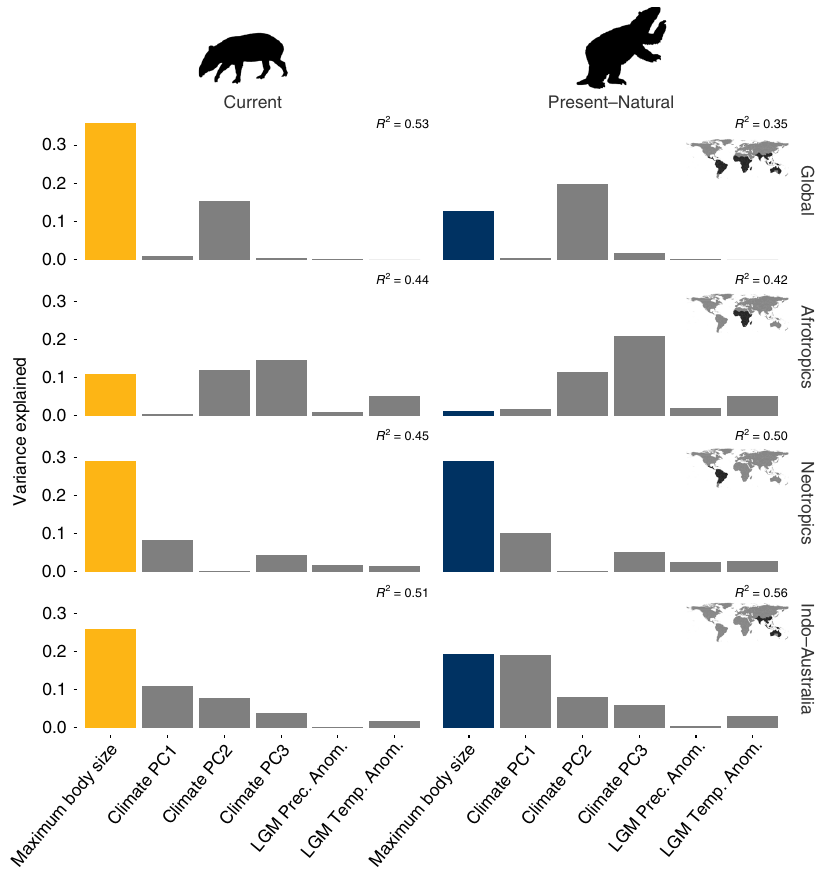
Fig. 3 Relative importance of predictors to maximum palm fruit size under current and present – natural scenarios. Bars represent the proportion of variance explained by each variable predictor in each model, and sum to the total variance explained by full ordinary least-squares (OLS) models with all predictor variables included ( R 2 ) as indicated at the top right of each panel. The bar representing the contribution of maximum body size as a predictor is plotted for current mammal (yellow) and Pleistocene assemblages that include extinct frugivores (dark blue). Gray bars represent current and paleoclimatic variables. Spatial extent of analysis is highlighted by dark shading in inset maps. Tapir silhouette from http://phylopic.org under public domain, except for the image of Mylodon for which we additionally acknowledge Julian Bayona (Zimices), under a CC-Attribution-NonCommercial